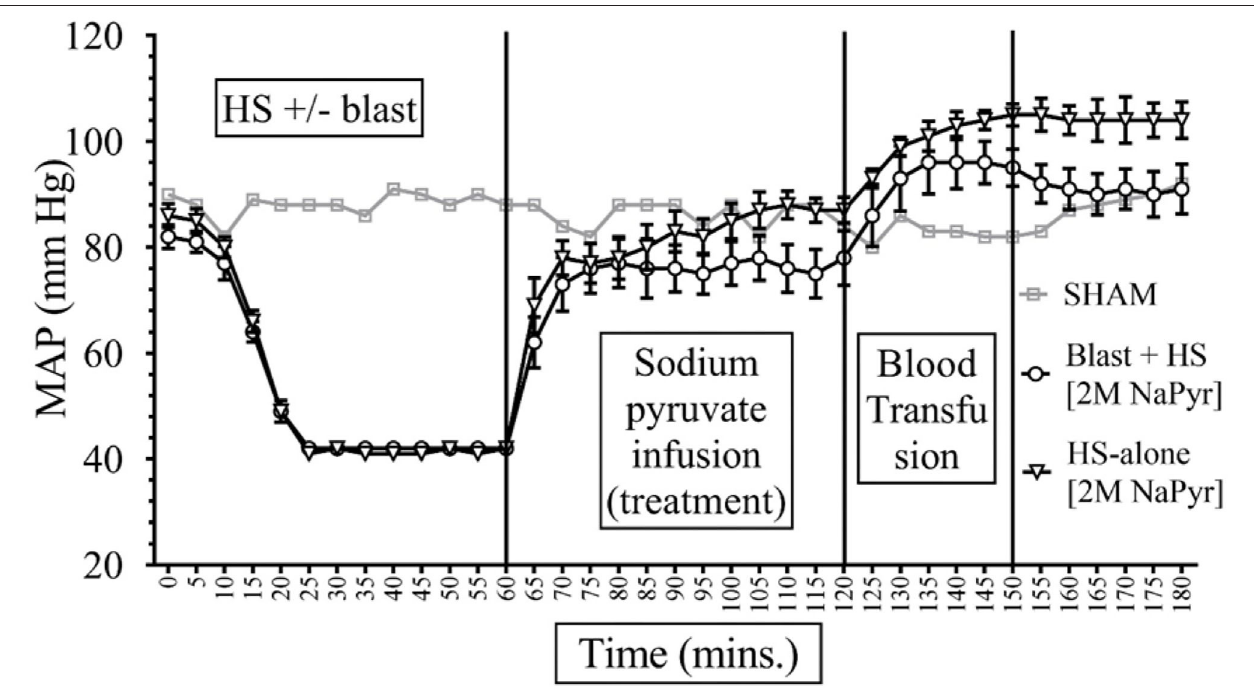
FIGURE 3 | Comparison of Mean Arterial Pressure (MAP) in Mean ± SE between the injury groups of 2M NaPyr infusion ( n = 8). NaPyr infusion increased the MAP near the baseline. The most significant increase was seen in the HS-alone group in comparison to the combined injury of high-intensity blast + HS. Blood transfusion further increased the MAP above the